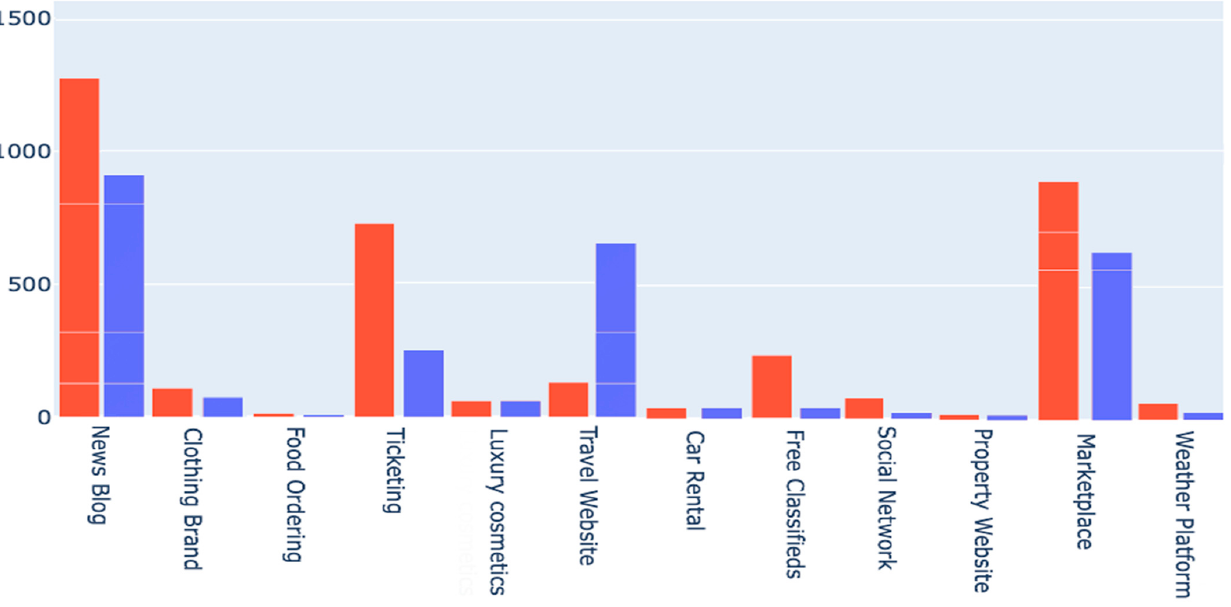
Figure 10. Presenting outcomes per industry into plots (red: older technology, blue: new technol ‐ ogy)—Axe DevTools (T7) .